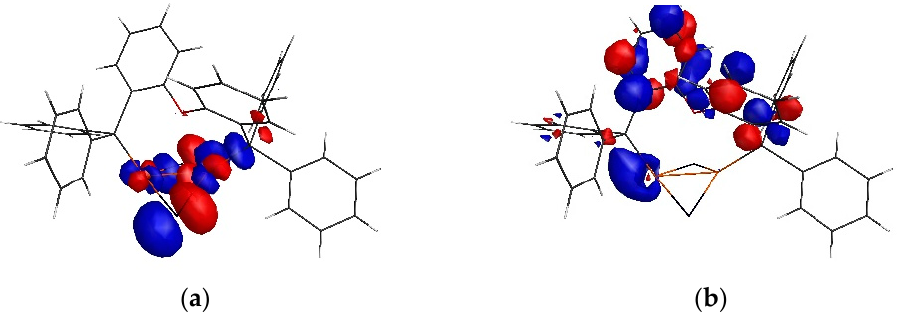
Figure 2. HOMO ( a ) and LUMO ( b ) plotting of CuPBr calculated at RB3LYP/LANL2DZ level, E HOMO = − 5.061 eV, E LUMO = − 1.045